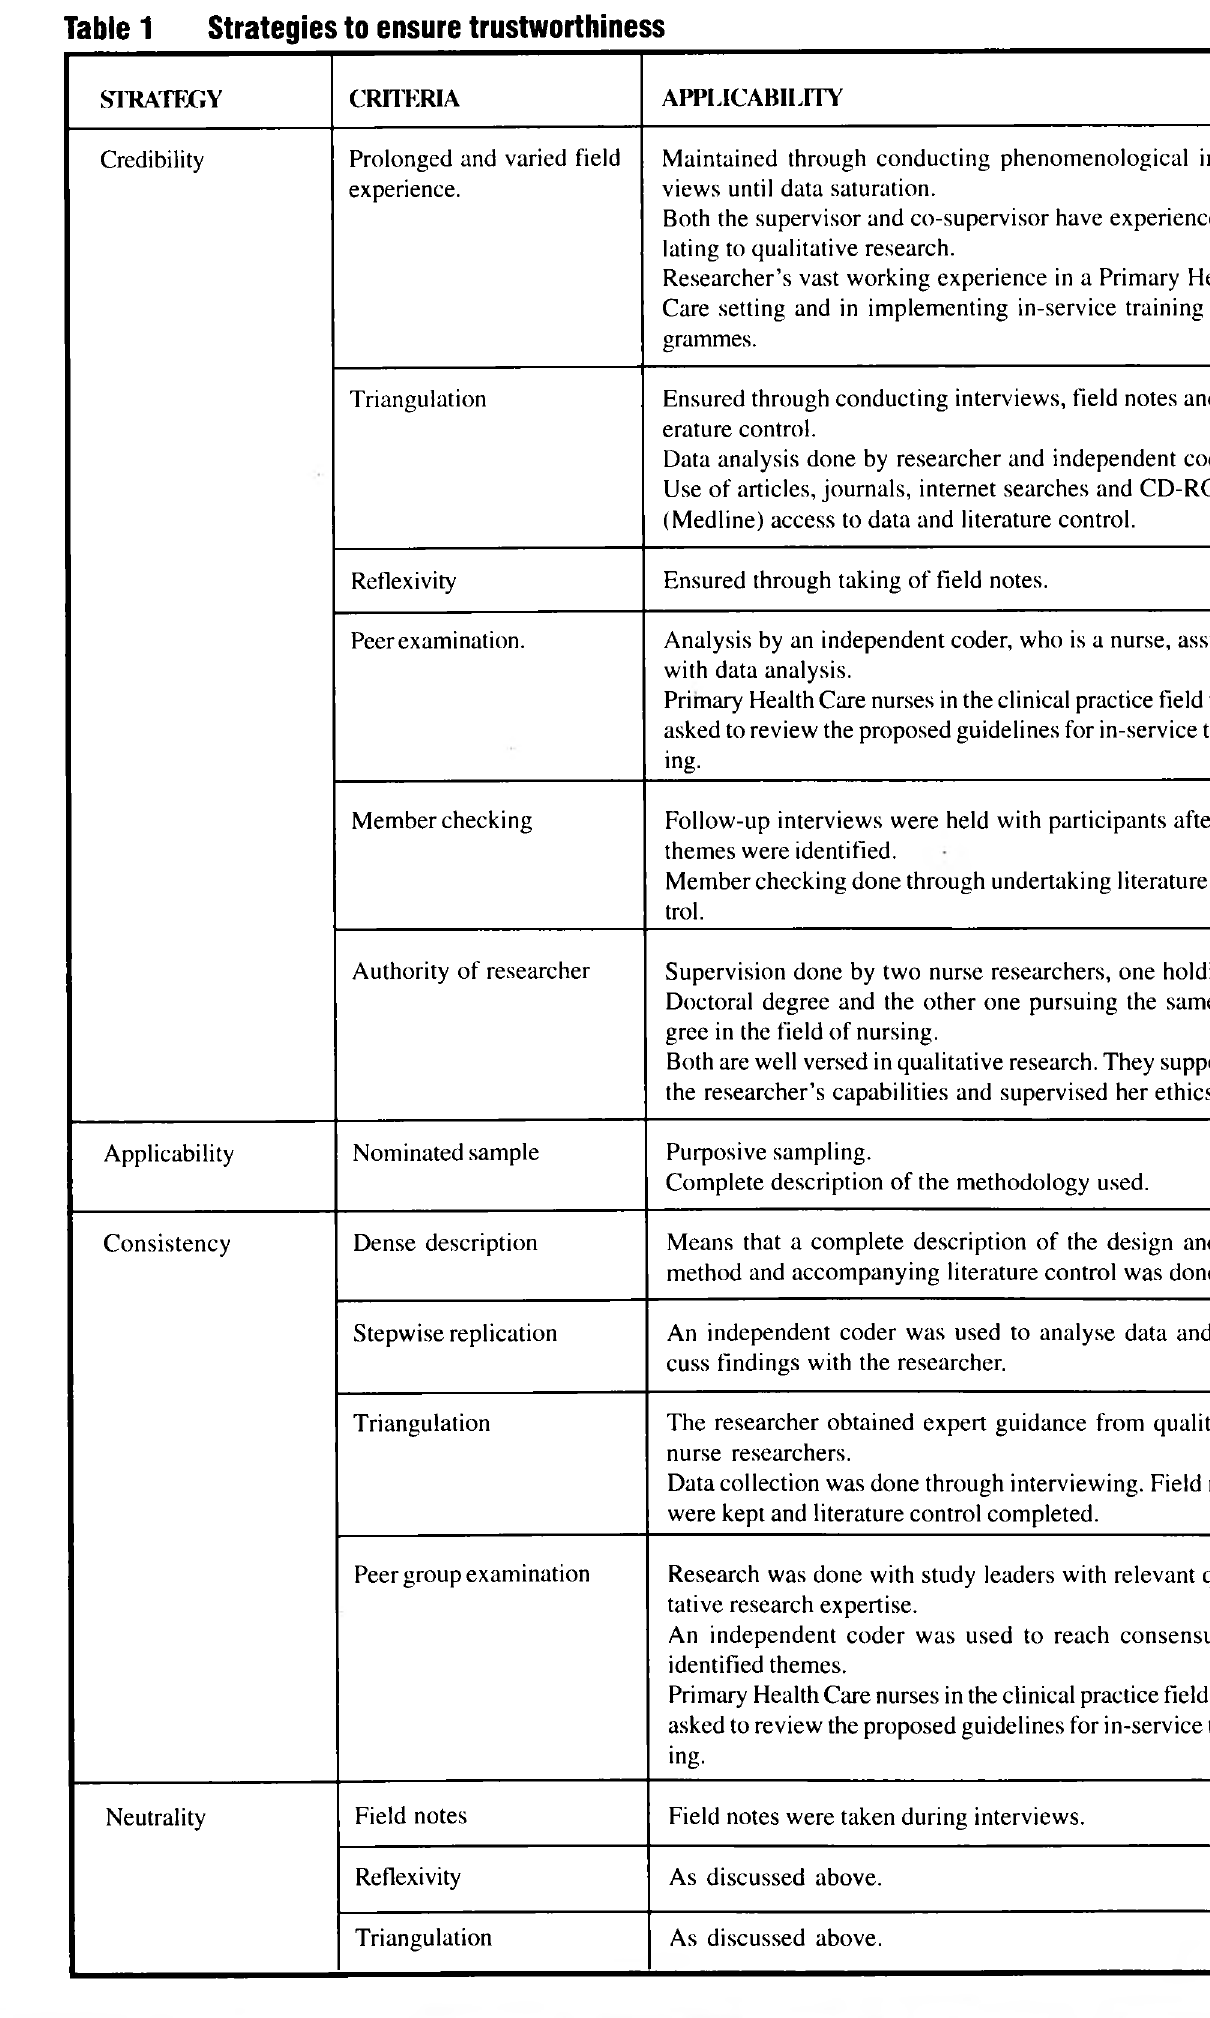
Strategies to ensure